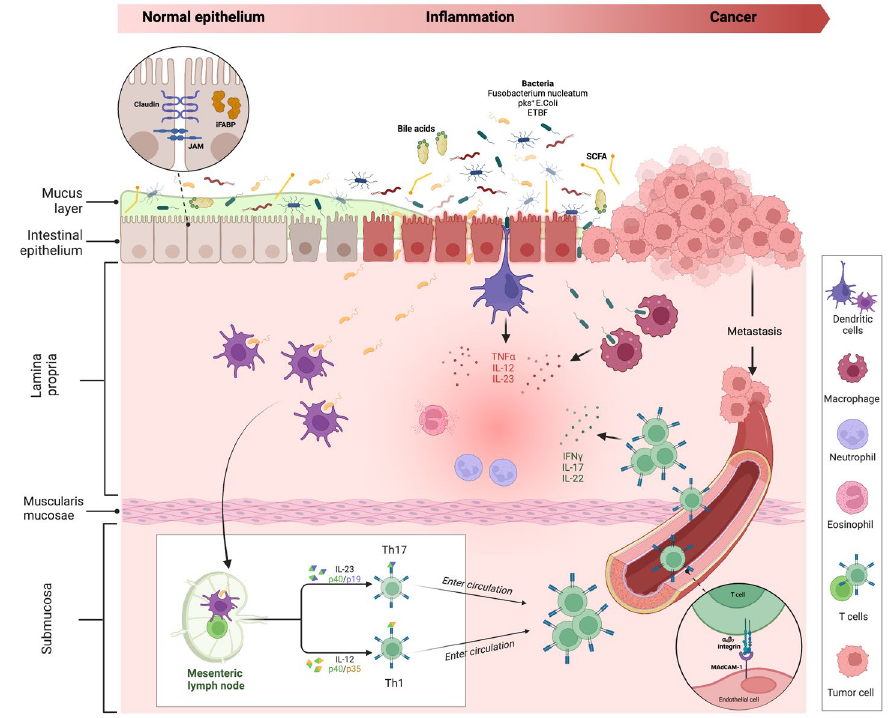
Figure 3. Intestinal inflammation and evolution to cancer in IBD . The impairment of the mucus layer and epithelial barrier, associated with dysbiosis, determines the inflammatory response, leading to IBD disease development and possible cancer evolution. Bile acids and small-chain fatty acids participate in initiating this process. In the lamina propria, dendritic cells and macrophages, after their interaction with intestinal microbes, determine the activation of innate immune cells through the release of numerous cytokines (neutrophils, eosinophils, etc.) and trigger the adaptative (Th1 and Th17) immune cells differentiation in mesenteric lymph nodes. Activated T cells, through a vascular homing mediated by the alfa4-beta7–MAdCAM-1 pathway, reach the intestinal lamina propria and spread the inflammatory process. The persistence of inflammation can lead to carcinogenesis and metastasis. Proteins involved in maintaining gut barrier function, such as intestinal fatty acid binding protein and tight junction proteins (shown in the dotted-line circle box in the upper left corner of the figure), have been proposed as potential biomarkers for cancer detection. Created with “Biorender.com”. Abbreviations: E. coli, Escherichia coli; ETBF, Enterotoxigenic